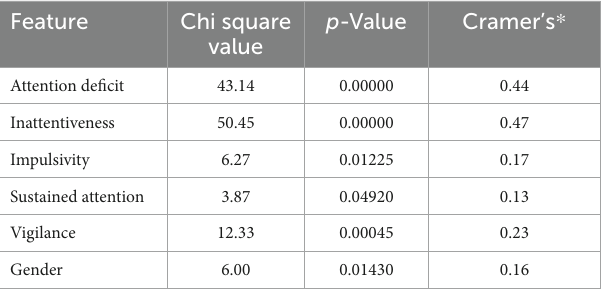
TABLE 3 Chi-square test of independence